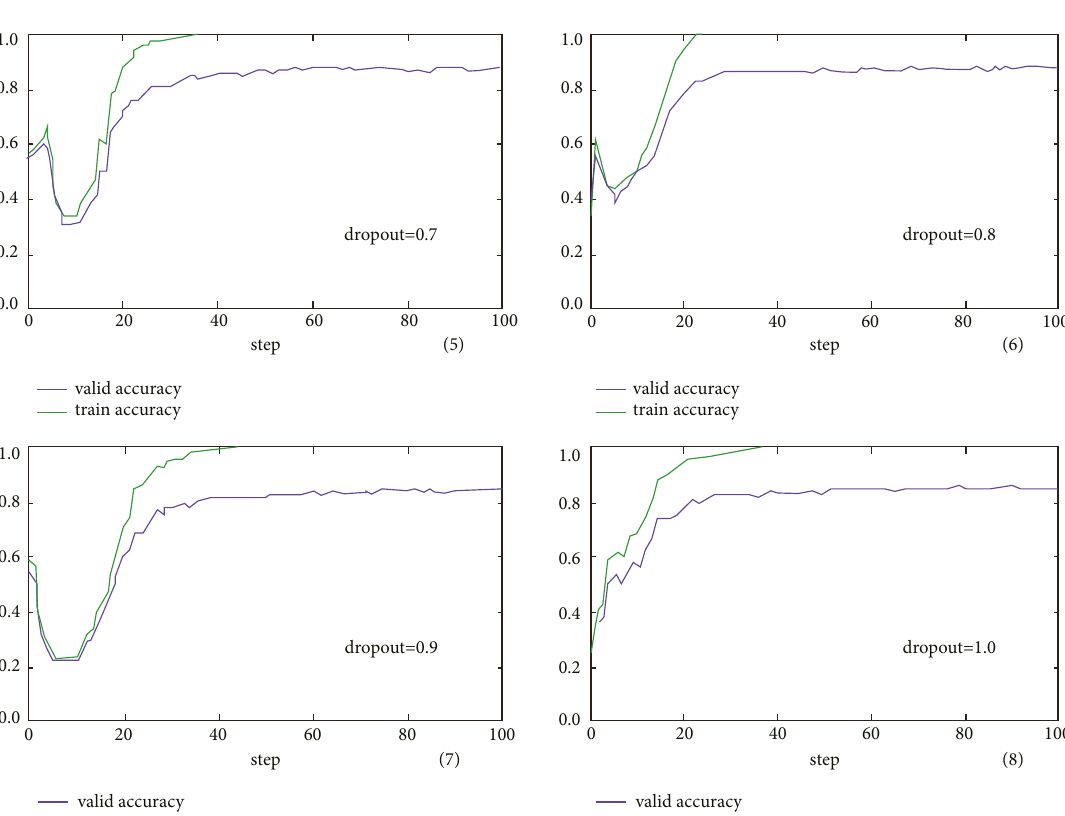
Figure 15: Changes of correct rate under different dropout in training process (1).